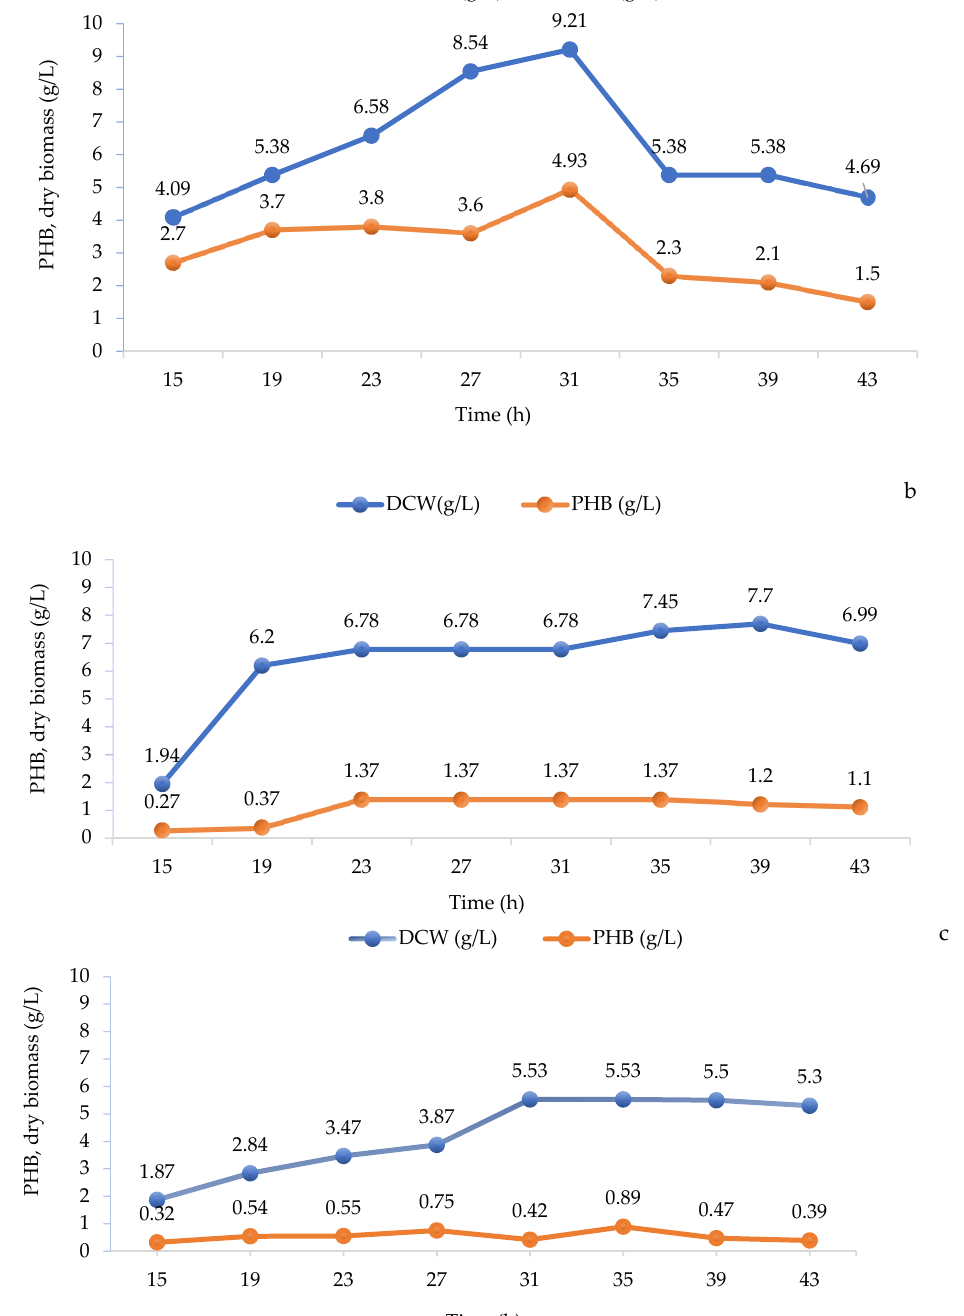
AzFw—5 ′ ATGGATCAAGCCACCTCCTTCG- CAAGTTTCTG 3 ′ ; BaRv—5 ′ TCACCGGCATTGCCATTACCATTACCATTTCCG 3 ′ — BaFw—5 ′ GTAACAGGCGGATCTAAAGGTATCGGGG 3 ′ ) were developed using Prime 3.0 software employing published PHB synthase gene sequences of other bacteria in the database. The fragment was approximately 800 bp, representing a partial phbB gene that was amplified in two selected bacterial isolates using a set of primers BmRv—BmFw and BaRv—BaFw. However, one pair of AzRv—AzFw primers led to an amplification of the product fragment approximately equal to 1704 bp, representing the complete phbC gene in all isolates (Figure 4). PHB synthase is an important enzyme involved in the biosyn- thetic pathway of PHB. The detection of the phbC gene responsible for encoding this en- zyme in the bacterial genome can be considered as a sign of PHB production by the cor- responding bacterial isolate. In earlier studies, PHB synthase genes were also amplified,